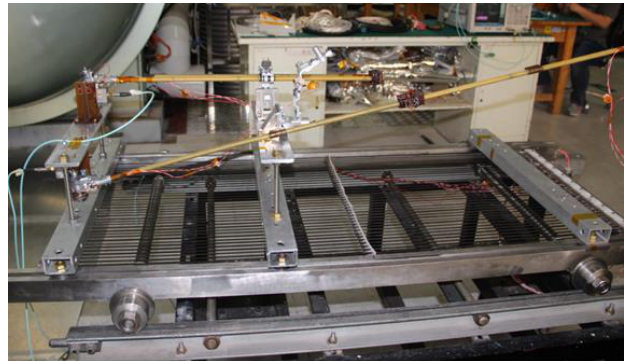
Figure 6. Thermal test preparation. The transmitting antenna is deployed and the receiving antenna is folded.